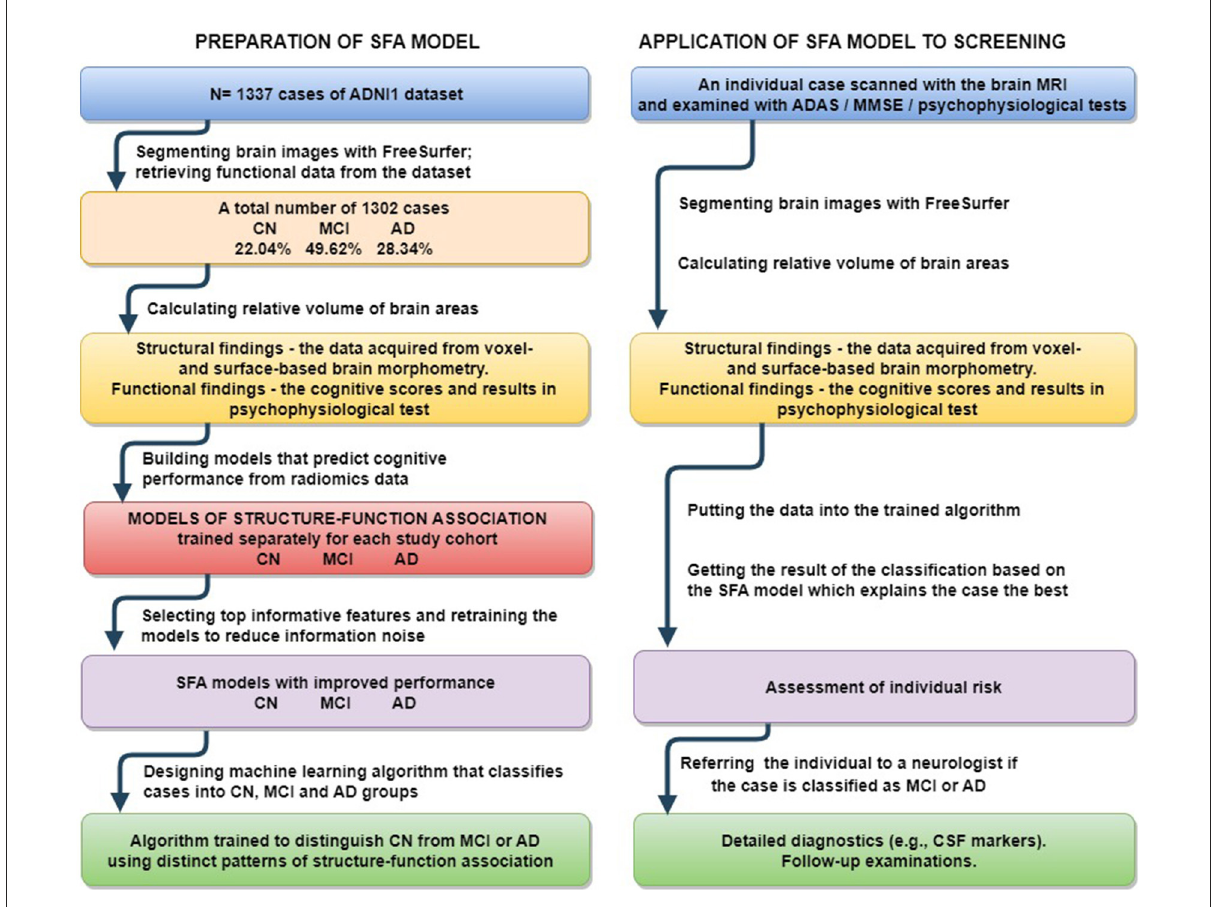
FIGURE1 Preparation of proposed SFA classification model and its application to screening for early stage MCI and Alzheimer’s